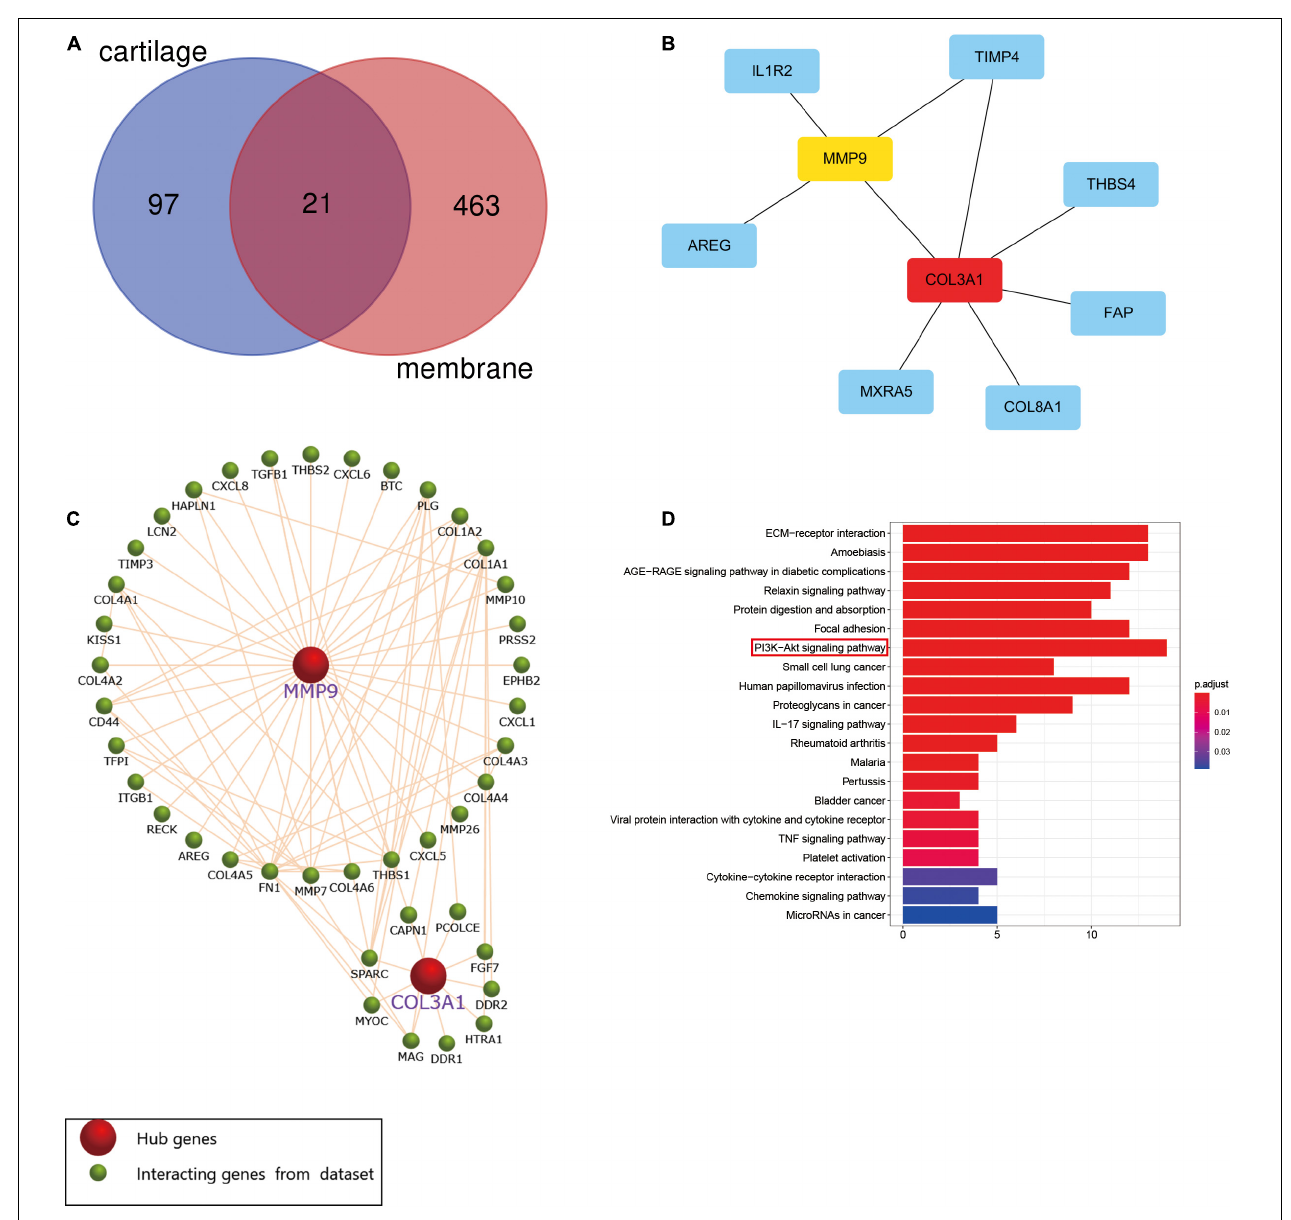
FIGURE 3 | Screening of hub genes and functional analysis. (A) Twenty-one differentially expressed genes (DEGs) intersected between the cartilage samples and the synovial membrane samples. (B) Protein–protein interaction (PPI) network of the 21 DEGs and two hub genes screened by the degree method (degree > 4) using cytoHubba. A higher ranking is represented by a redder color. (C) MMP9 and COL3A1 interacting genes indicated using Funrich software. (D) Kyoto Encyclopedia of Genes and Genomes (KEGG) pathway enrichment analysis of MMP9 and COL3A1 interacting